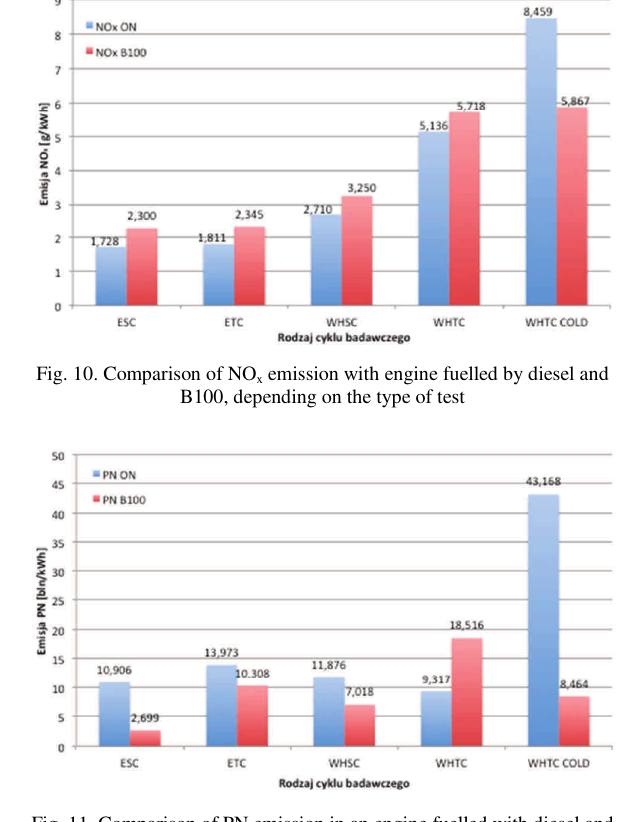
Fig. 11. Comparison of PN emission in an engine fuelled with diesel and B100, depending on the type of